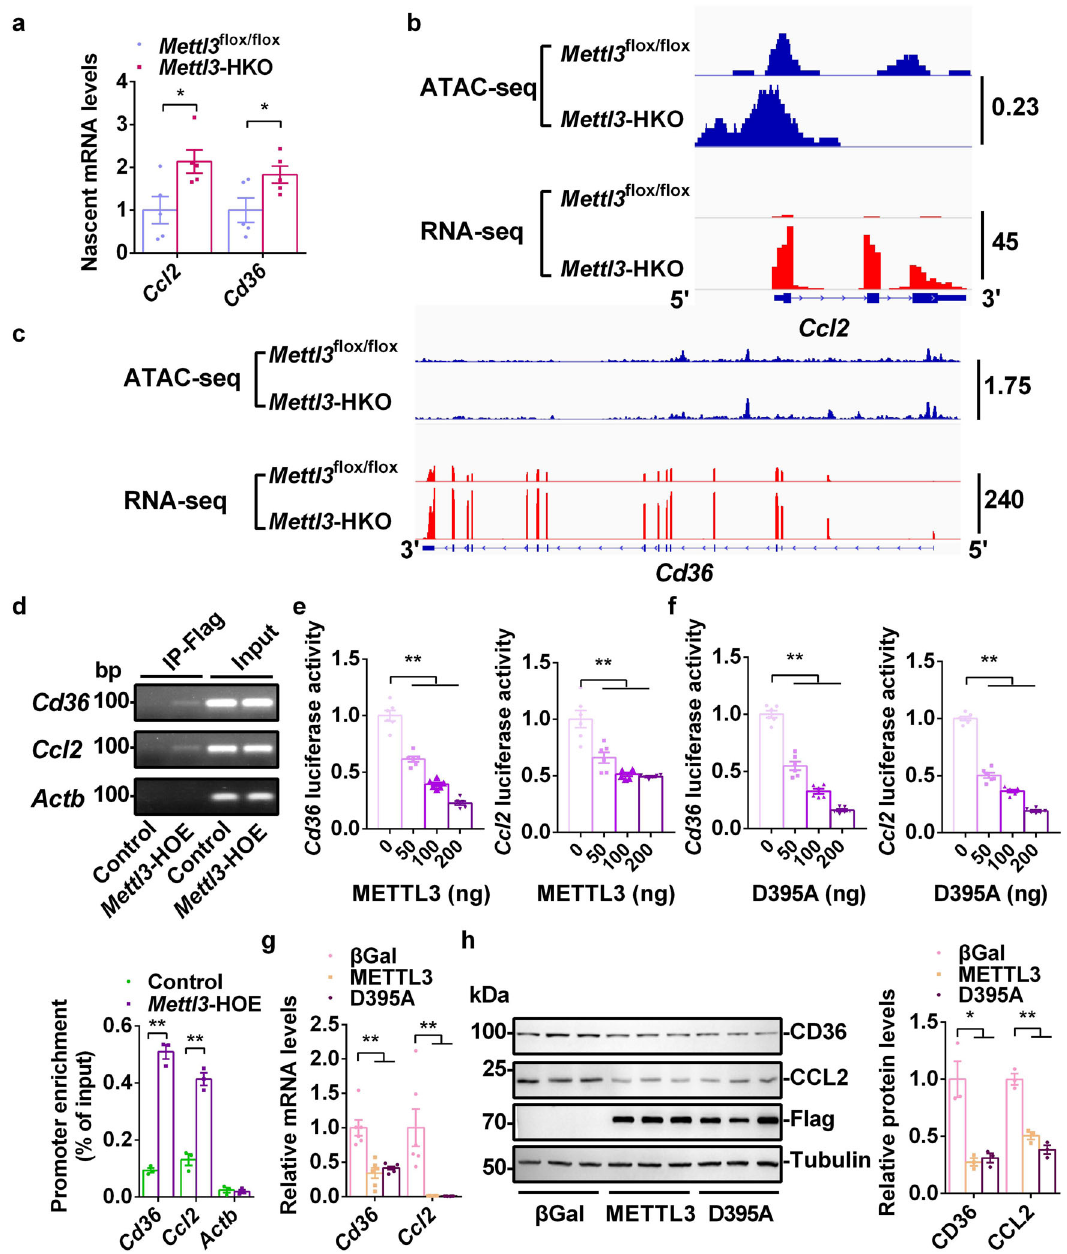
Fig. 8 METTL3 regulates Cd36 and Ccl2 transcription. a Nascent Cd36 and Ccl2 mRNA levels in primary hepatocytes isolated from Mettl3 fl ox/ fl ox and Mettl3- HKO mice ( n = 5 for each group; Cd36 , P = 0.0261; Ccl2 , P = 0.0439). b , c ATAC-seq peaks in the promoters of Cd36 and Ccl2 genes and RNA-seq peaks of Cd36 and Ccl2 transcripts in the livers of Mettl3 fl ox/ fl ox and Mettl3- HKO at 8 weeks old. d Binding of Flag-METTL3 to the promoters of Cd36 and Ccl2 were assessed in the livers of control and Mettl3 -HOE mice at 8 weeks old by ChIP. The liver samples were immunoprecipitated with Flag beads. Immunoprecipitated DNA was extracted for PCR analysis. Representative image and statistic analysis were shown ( n = 3 for each group; Cd36 , P < 0.0001; Ccl2 , P = 0.0007; Actb , P = 0.666). The samples were derived from the same experiment and the gels were processed in parallel. e , f Cd36 or Ccl2 luciferase reporter plasmids were co-transfected with METTL3, D395A, or empty expression vector by polyethyleneimine (Sigma) into HEK293T cells. 48 h later, HEK293T cells were lysed in reporter lysis buffer, and luciferase activity was measured and normalized to β -Gal activity ( n = 6 for each group; Cd36 , P < 0.0001; Ccl2 , P < 0.0001). g , h Primary hepatocytes were infected with Ad- β Gal, Ad-METTL3 and Ad-METTL3 (D395A) adenovirus overnight, Cd36 and Ccl2 mRNA levels were measured by qPCR ( n = 6 for each group; for Cd36 , β Gal versus METTL3, P = 0.0008, METTL3 versus D395A, P = 0.0006; for Ccl2 , β Gal versus METTL3, P = 0.0044, METTL3 versus D395A, P = 0.0042). CD36 and CCL2 protein levels were measured by immunoblotting, quanti fi ed by ImageJ and normalized to Tubulin ( n = 3 for each group; for CD36, β Gal versus METTL3, P = 0.0111, METTL3 versus D395A, P = 0.0134; for CCL2, β Gal versus METTL3, P = 0.0012, METTL3 versus D395A, P = 0.0006). The samples were derived from the same experiment and the blots were processed in parallel. n was the number of biologically independent mice or cell samples. The cell culture experiments were repeated three times independently with similar results. Data represent the mean ± SEM. Signi fi cance was determined by unpaired two-tailed Student ’ s t test analysis. * P < 0.05. ** P < 0.01. Source data are provided as a Source Data fi